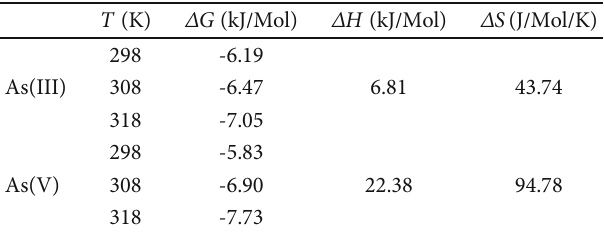
Table 4: Thermodynamic parameters of arsenic adsorption by